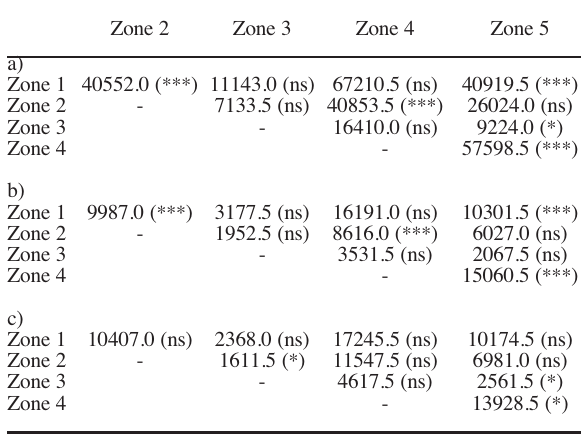
size of males, females and totals for each of the sam- pling zones are shown in Table 3. The mean size of the total number of crabs was largest in Zone 5, and smallest in Zone 1. There were significant differ- ences in total crab size between Zones 1 and 2, 1 and 5, as well as between 2 and 4, 3 and 5, and 4 and 5 (Table 4a). Significant differences in female size were found between Zones 1 and 2, 1 and 5, 2 and 4, and between 4 and 5 (Table 4b). The mean size of females was largest in Zone 5, and smallest in Zone 1 (Table 3). Male size differed significantly between Zones 2 and 3, 3 and 5, and 4 and 5 (Table 4c). The largest males (mean size) were found in Zone 5, whilst the smallest mean size was found in Zone 3 (Table 3). Ovigerous females were present in all the sam- pling zones, showing a grand mean of 68.9% (n= 134; SD= 33.68). The least mean percentage of ovigerous females was found in Zone 3 (n= 23; mean= 24.0; SD= 41.85), and the highest in Zone 5 (n= 29; mean= 58.9; SD= 46.71). Significant differ- ences (Mann-Whitney test) were found between